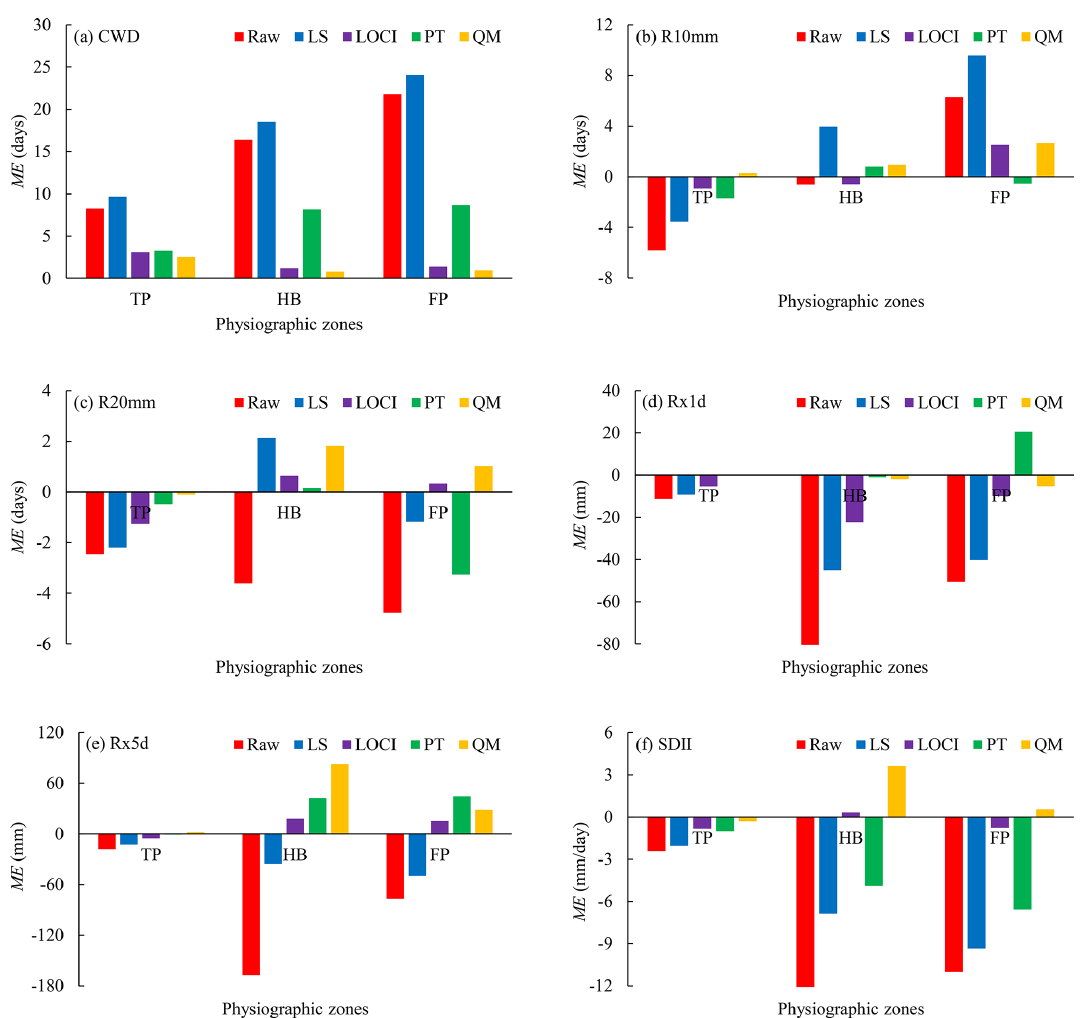
Figure 3. Mean error (ME) of (a) consecutive wet days (CWD), (b) number of heavy precipitation days (R10mm), (c) number of very heavy precipitation days (R20mm), (d) maximum 1d precipitation amount (Rx1d), (e) maximum 5d precipitation amount (Rx5d), and (f) simple daily intensity index (SDII) during June, July, August, and September (JJAS) for validation in the three different physiographic zones (TP, HB, and FP) of the